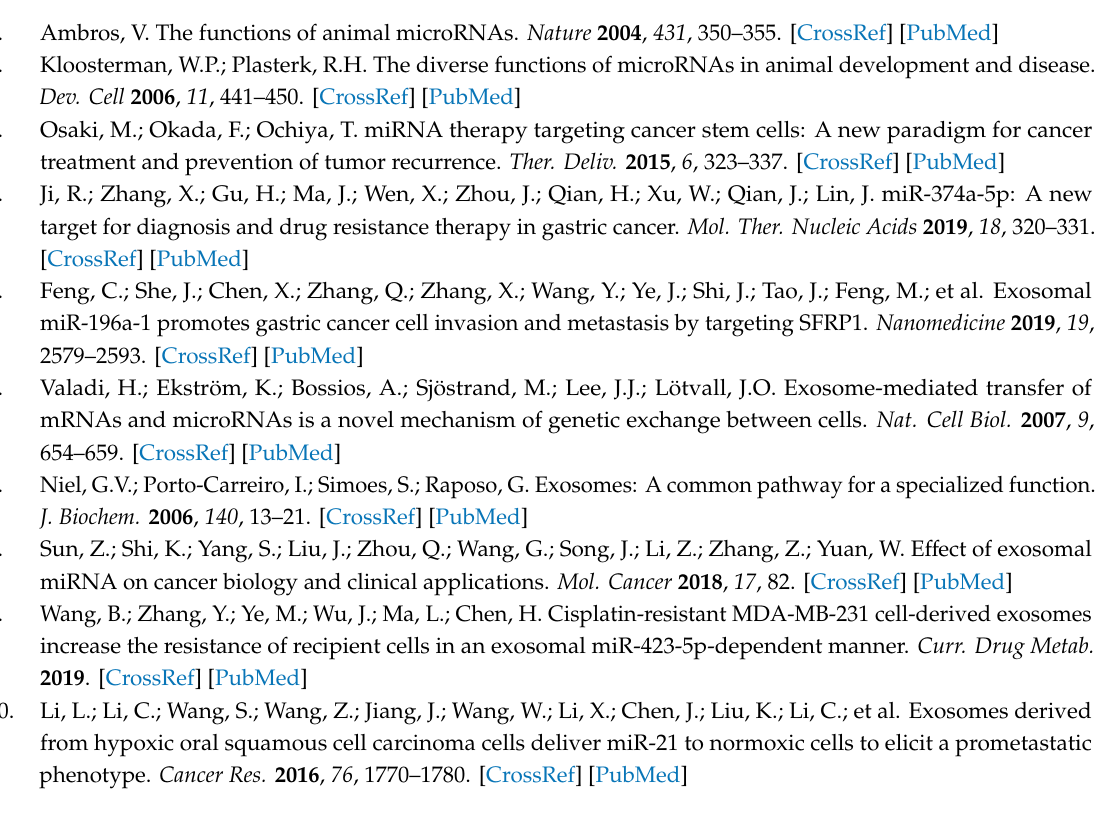
Figure S1: Cellular localization of fluorescently labeled anti-exosome antibodies in heLa cells (after 24 h of incubation). Figure S2: SEC analysis of IgG-9r. Figure S3: Standard SH (acetyl Cysteine) calibration curve using Ellman’s Reagent (a), and quantification of the introduction number of SH groups to IgG (b). Figure S4: Gel mobility shift assay of the [anti-CD63 IgG-9r / anti-miR] complex (a). Figure S5: In vivo distribution of Alexa-647 labeled anti-CD63